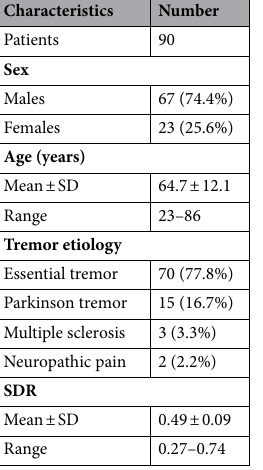
Table 2. Characteristics of the study population. SDR skull-density ratio, SD standard